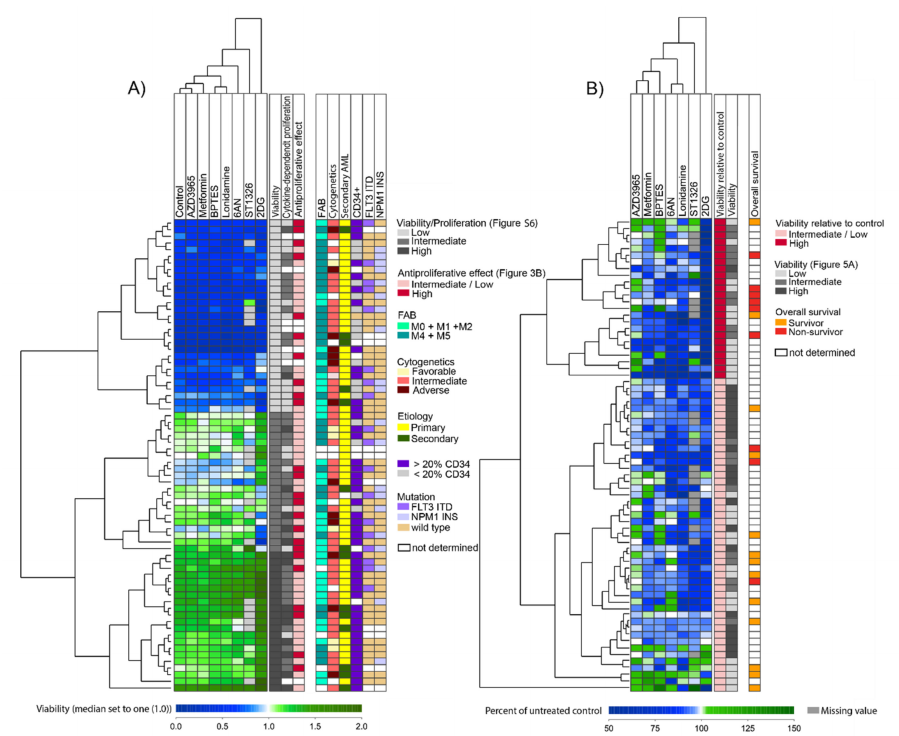
Figure 5. Unsupervised hierarchical cluster analysis based on the e ff ects of metabolic inhibitors on AML cell viability. Primary AML cells were seeded into suspension cultures in medium supplemented with cytokines. The cells were treated with metformin 2.5 mM, 2DG 0.6 mM, 6AN 100 µ M, BPTES 20 µ M, ST1326 50 µ M, lonidamine 300 µ M and AZD3965 200 nM or untreated controls (medium alone) for 48 h before e ff ects on cell viability were determined using the AnnexinV / PI flow cytometric assay. ( A ) Cluster analysis based on the viability of primary AML cells after treatment with metabolic inhibitors. The analysis is based on the percentage of viable cells in cultures after 48 hours with or without inhibitor treatment. The data obtained from the 72 patient samples were normalized to the corresponding median level (median set as 1.0). Patients could then be divided into three main subsets; one upper subset showing low viability (shown as white), one with intermediate viability (light grey) and one with generally high viability (dark grey) after inhibitor treatment. These subsets are indicated in the column to the right of the cluster, together with a column showing the degree of AML cytokine-dependent cell proliferation (based on Figure S6) and the e ff ect of metabolic inhibitors on cell proliferation (based on Figure 3B), as well as biological and clinical characteristics for the individual patients (i.e., FAB classification, karyotype, etiology, CD34 expression, FLT3 -ITD and NPM1 mutations). ( B ) Cluster analysis based on the relative viability of AML cells after treatment with metabolic inhibitors for 48 h. The analysis is based on the relative e ff ect of metabolic inhibitors on AML cell viability after 48 hours treatment, that is the viability in cell cultures treated with inhibitors relative to the viability in control cultures (untreated cultures set to 100%). Cluster analysis separated the 72 AML patients into two main subsets, one upper patient subset showing reduced viability after treatment with metabolic inhibitors (shown in dark red, 24 patients) and one lower subset with intermediate / low e ff ects on viability (light red). The subsets are indicated in the column to the right of the figure, along with a column showing inhibitor e ff ects on AML cell viability normalized to median levels (Figure 5A) and the classification of younger patients receiving intensive chemotherapy as survivors or non-survivors (i.e., dying from resistant / relapsed